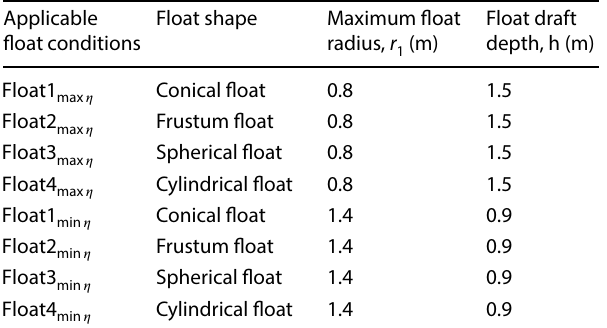
Table 6 Selection of various factors for different applicable condi- tions